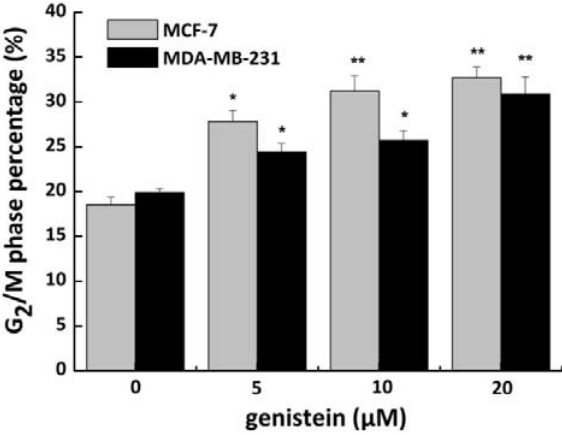
/M phase MCF-7 and MDA-MB-231 Figure 5. Effect of genistein on the percentage of G 2 cells. Cells were incubated with genistein (0, 5, 10 and 20 μ M) for 24 h and then analyzed by flow cytometry. All data are presented as means ± SD from three independent experiments. * p < 0.05, ** p < 0.01 versus control group.